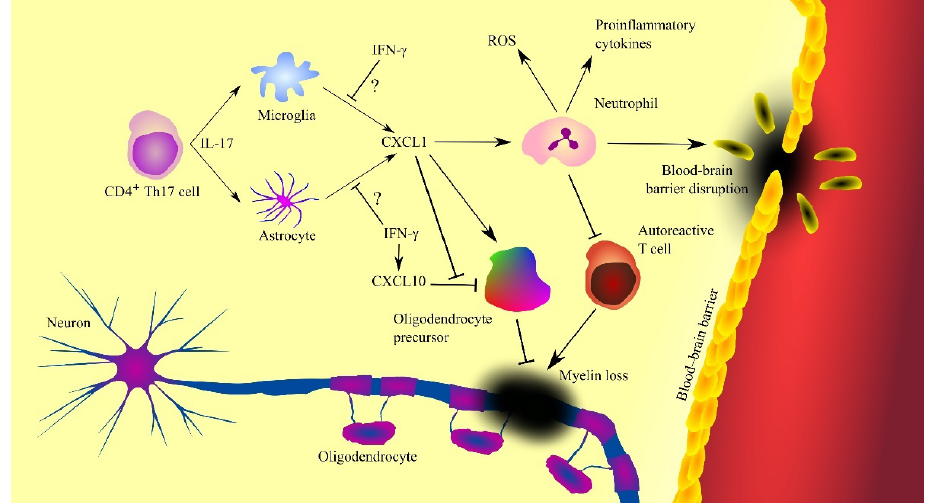
Figure 5. Involvement of CXC motif chemokine ligand 1 (CXCL1) in the mechanisms of multiple sclerosis. CXCL1 expression is increased by interleukin-17 (IL-17) produced by T helper type 17 (Th17) cells, which triggers the recruitment of neutrophils, cells contributing to the progression of the disease by producing reactive oxygen species (ROS), proinflammatory cytokines and causing blood-brain barrier (BBB) disruption. However, neutrophils can also inhibit the destructive effects of autoreactive T cells. CXCL1 also acts on oligodendrocyte precursor cells by inducing their pro- liferation and inhibiting CXC motif chemokine ligand 10 (CXCL10)-induced apoptosis of these cells. Oligodendrocyte precursor cells differentiate into oligodendrocytes, leading to remyelination and disease regression. Abbreviations: CXCL1—CXC motif chemokine ligand 1; CXCL10—CXC motif chemokine ligand 10; IFN- γ —interferon- γ ; IL-17—interleukin-17; ROS—reactive oxygen